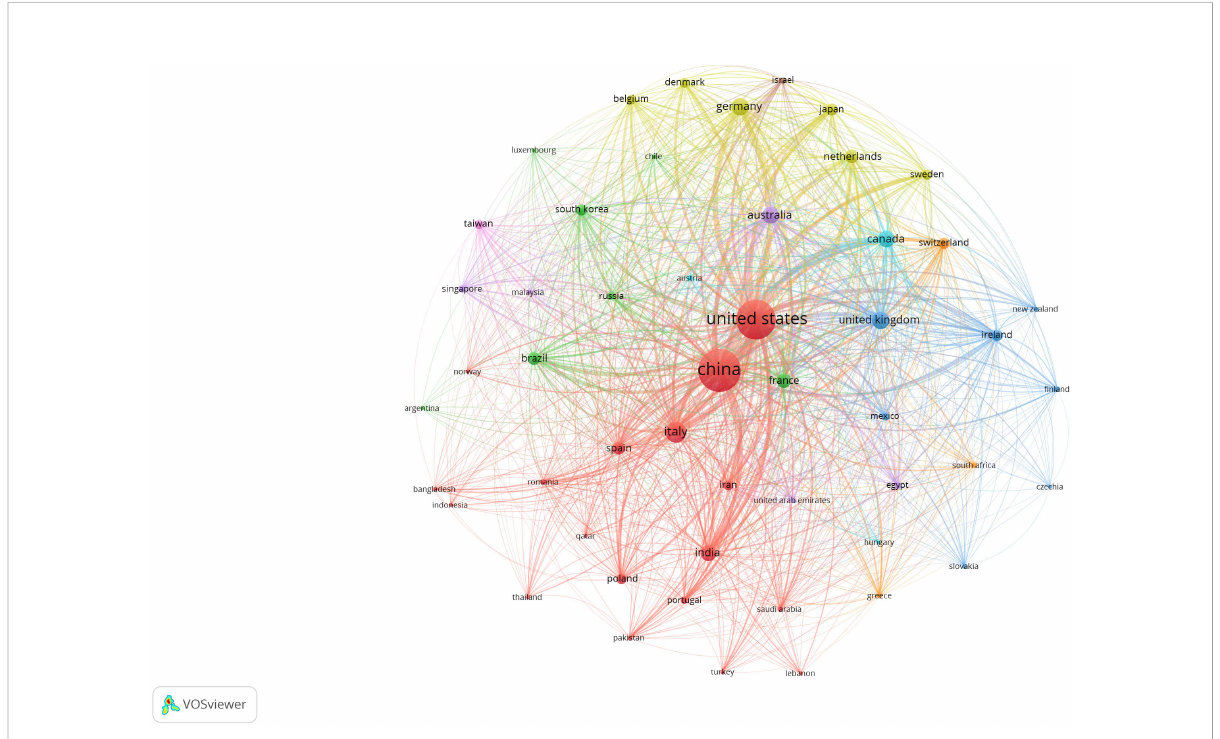
FIGURE 2 Network visualization map showing bibliographic coupling of the countries conducting research in the fi eld of gut – lung axis and SCFAs collectively. Connecting line thickness is directly proportional to the coloration strength among the countries. The percentage of association is presented by node and its size. The network map was generated using VOS viewer visualization